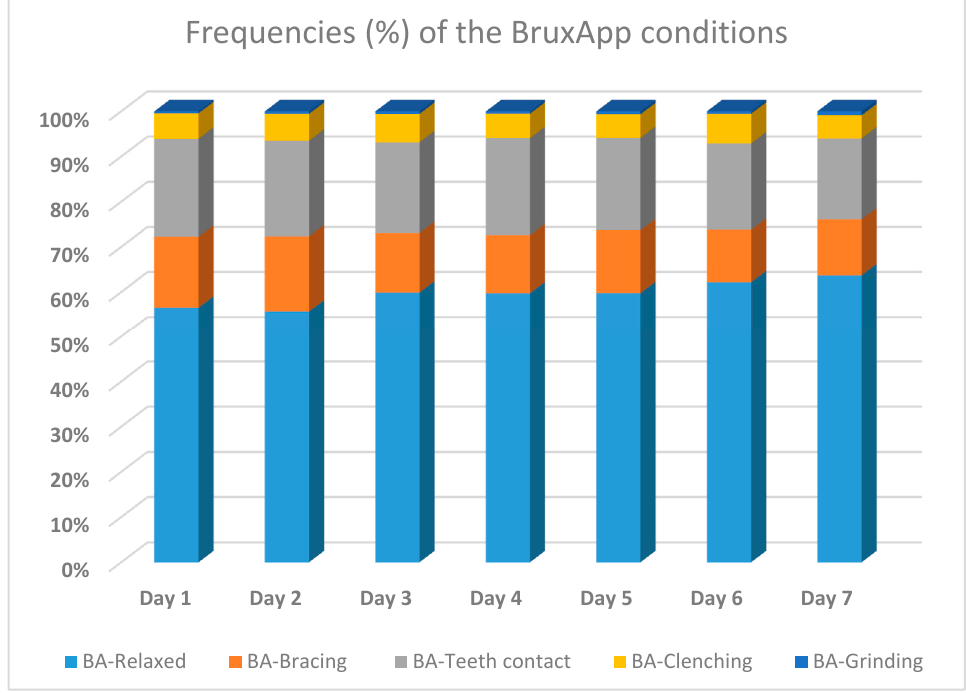
Figure 1. Frequencies of the BruxApp conditions per seven days of report. Table 1. Correlations between awake bruxism (AB) as defined by single-point self-report and BruxApp conditions.